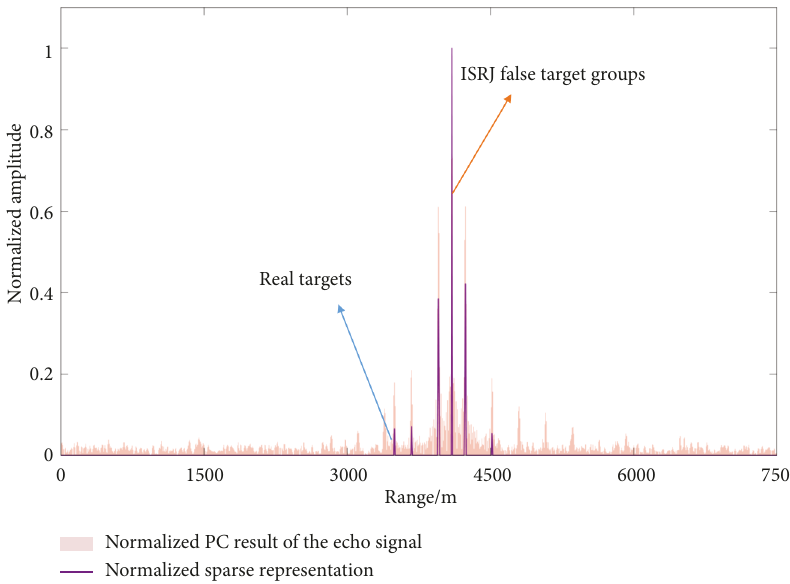
Figure 14: Spare representation of the echo signal in the frequency shifting situation.